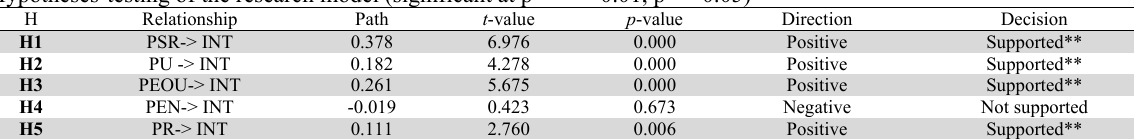
Hypotheses-testing of the research model (significant at p** < = 0.01, p* < 0.05)